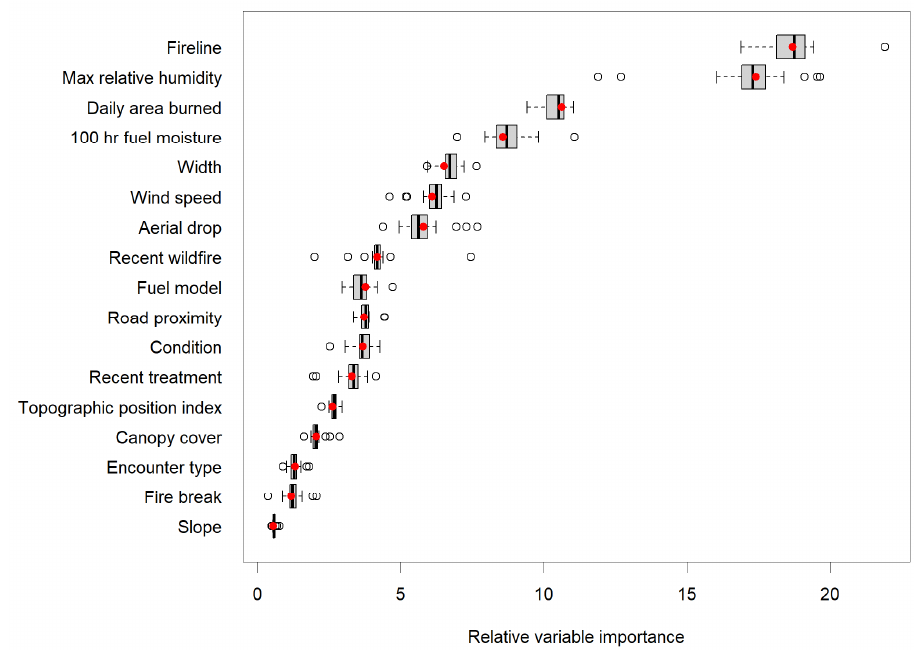
Figure 5. Relative variable importance for Model 2 with the full training data (red dots) and variation in relative variable importance for Model 2 from iteratively withholding each fire from the training data (boxplots).